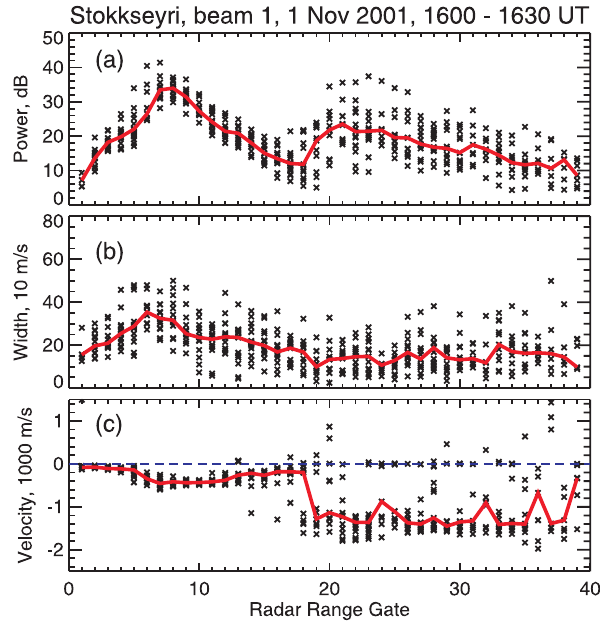
Fig. 3. Stokkseyri radar velocity-range-gate-time plots for three typical events considered in this study. All data are for beam 1. Notice that the color scales are not all the same.